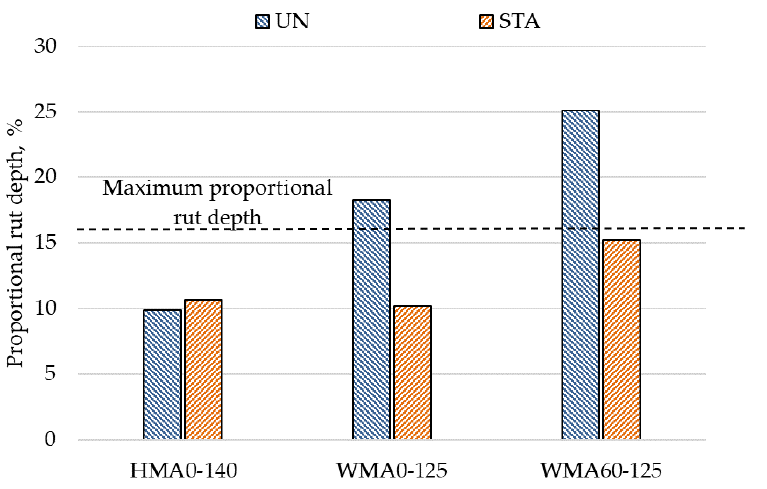
Figure 5. Proportional rut depth results.